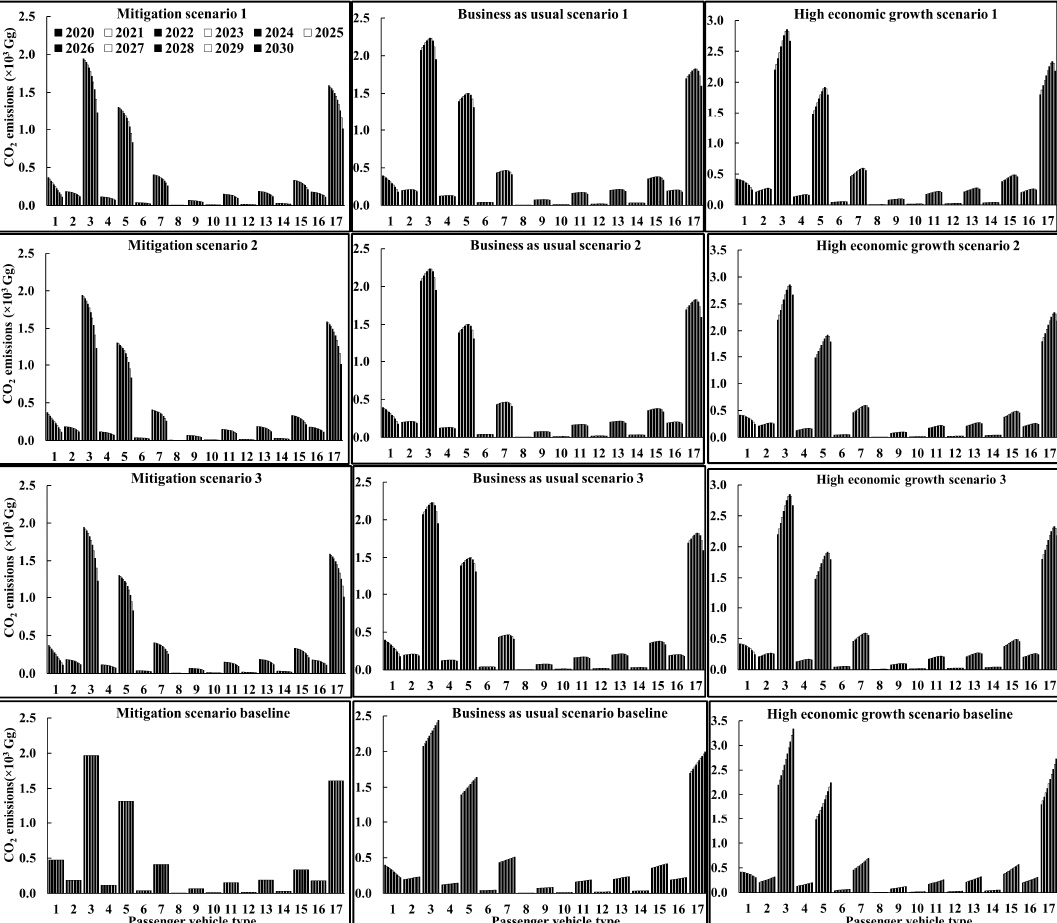
Figure 4 Figure 4. Annual CO 2 emissions per vehicle class from year 2000 to 2017 for all the scenarios and di ff erent vehicle types (where 1 = mini car (petrol); 2 = small vehicle (diesel); 3 = small vehicle (petrol); 4 = lower medium vehicle (diesel); 5 = lower medium vehicle (petrol); 6 = medium vehicle (diesel); 7 = medium vehicle (petrol); 8 = upper medium vehicle (diesel); 9 = upper medium vehicle (petrol); 10 = sport vehicle (diesel); 11 = sport vehicle (petrol); 12 = o ff road vehicle (diesel); 13 = o ff road vehicle (petrol); 14 = MPV (diesel); 15 = MPV (petrol); 16 = SUV (diesel); 17 = SUV